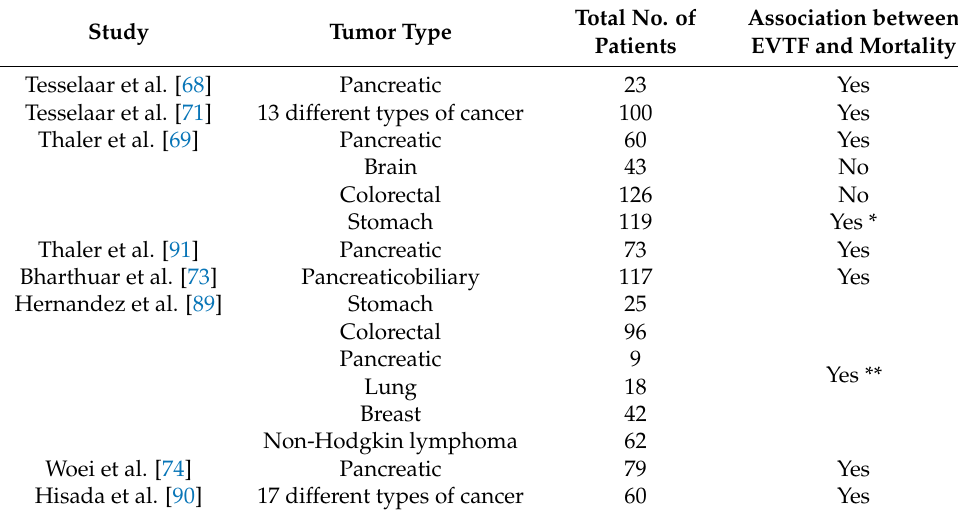
Table 2. Studies evaluating the association between extracellular vesicle tissue factor activity and survival in patients with